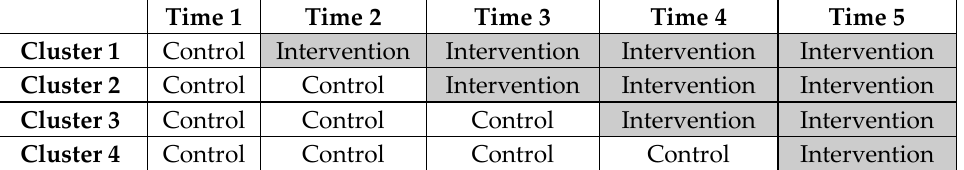
Figure 1. Trial design.